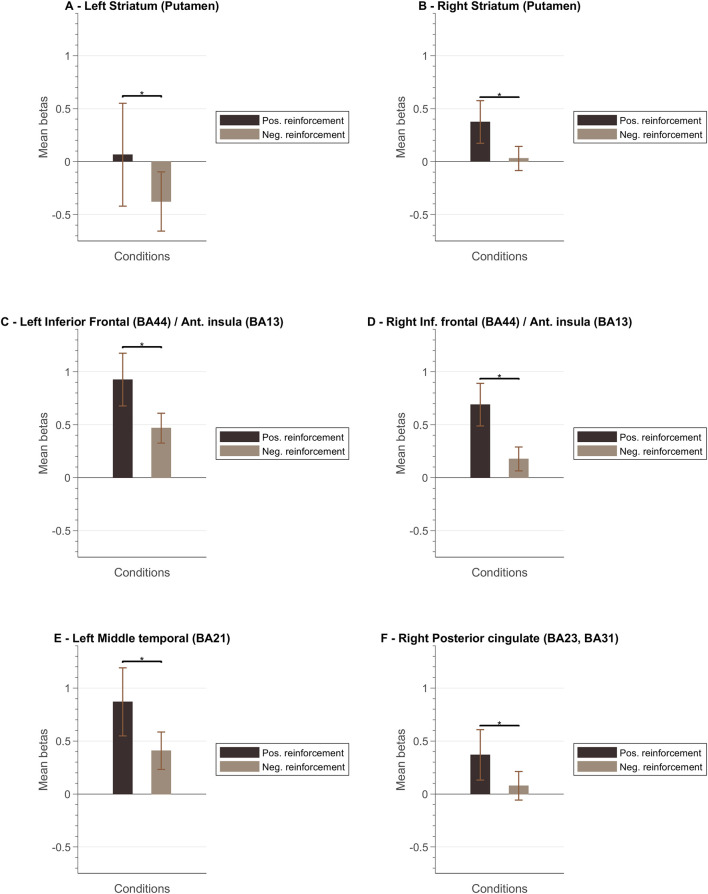
Mean beta values per ROI. The left columns for each ROI correspond to the mean bata value associated to the “positive reinforcement” events and the right columns to the “negative reinforcement” events (the whiskers represent the SEM) for the following ROIs: (A) Left Striatum (Putamen); (B) Right Striatum (Putamen); (C) Left Inferior Frontal Cortex (Brodmann Area, BA, 44)/Anterior Insula (BA13); (D) Right Inferior Frontal Cortex (BA44)/Right Anterior Insula (BA13); (E) Left Middle Temporal Cortex (BA21); (F) Right Posterior Cingulate Cortex (BA23, BA31).